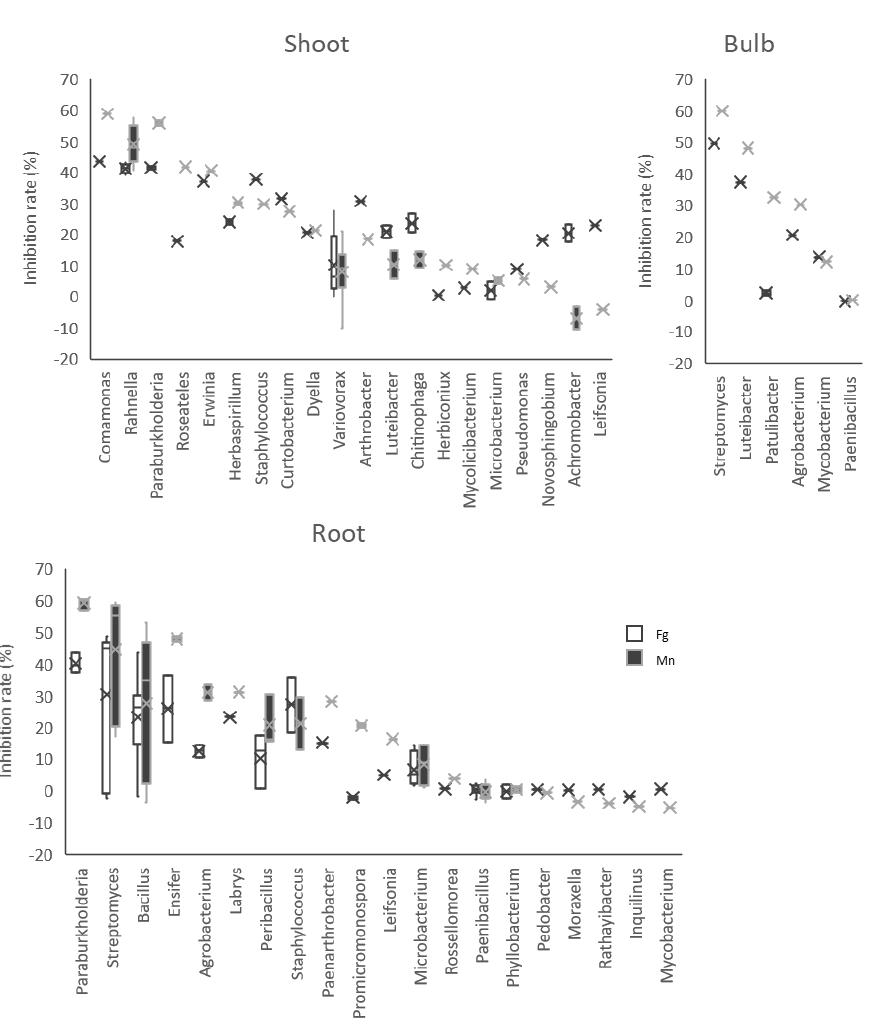
Figure 9. Growth inhibition rate against F. graminearum (Fg) and M. nivale (Mn) by genus of bacterial isolates in three different tissues: shoot, bulb and root.